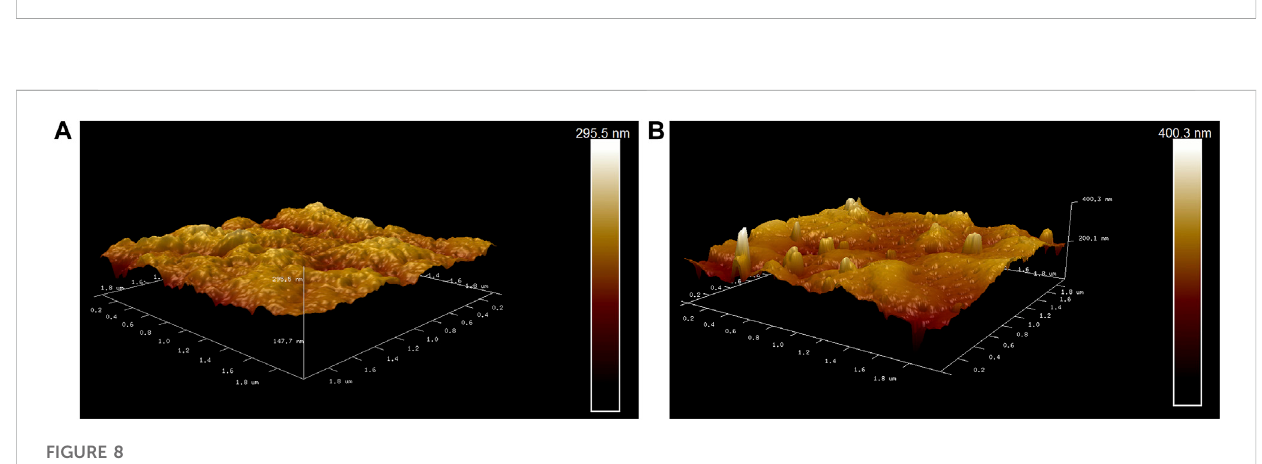
FIGURE 7 XPS fi tting spectra of PVDF and PVDF/DA membranes. (A) PVDF-C1s, (B) PVDF/DA-C1s, (C) PVDF-N1s, and (D) PVDF/DA-N1s.